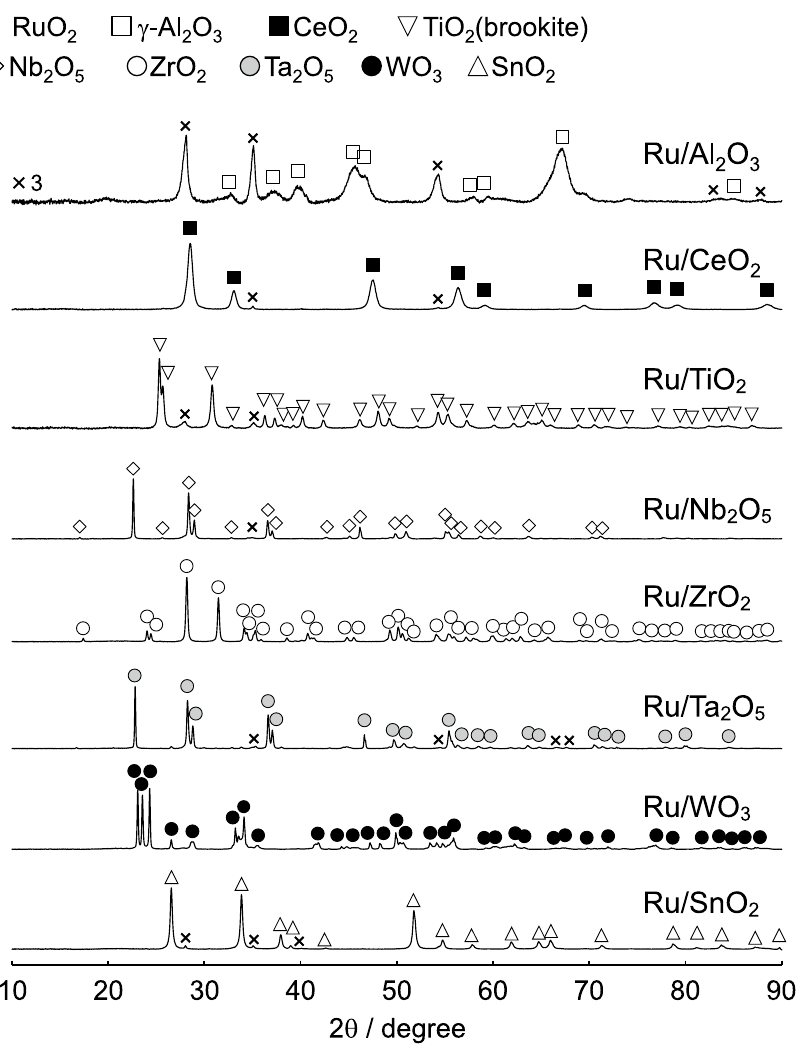
Figure 1. PXRD patterns of 5.0 wt% Ru supported on various different metal oxide materials prepared by impregnation, followed by drying and calcination at 600 °C for 3 h in